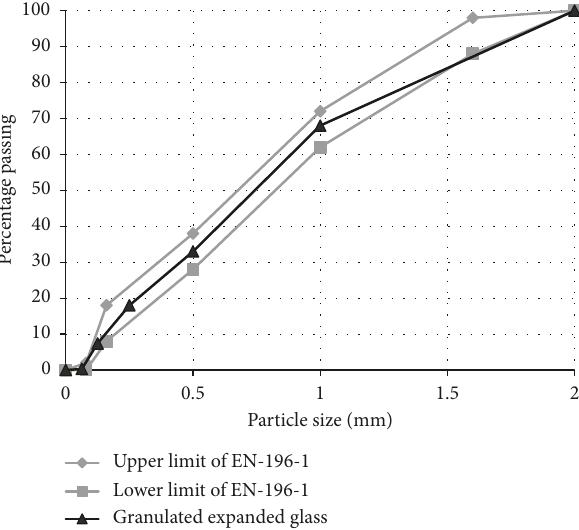
Figure 7: Cumulative grain size distribution of GFG and limits for sand according EN-196-1 standard